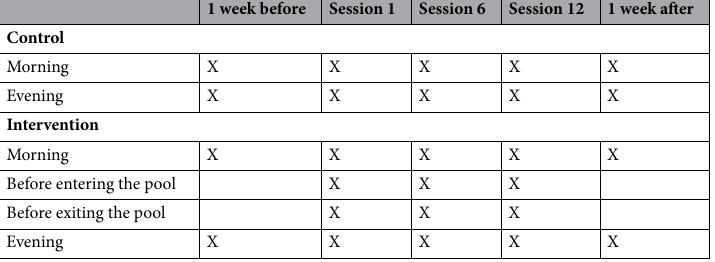
Table 2. Time schedule for saliva sample